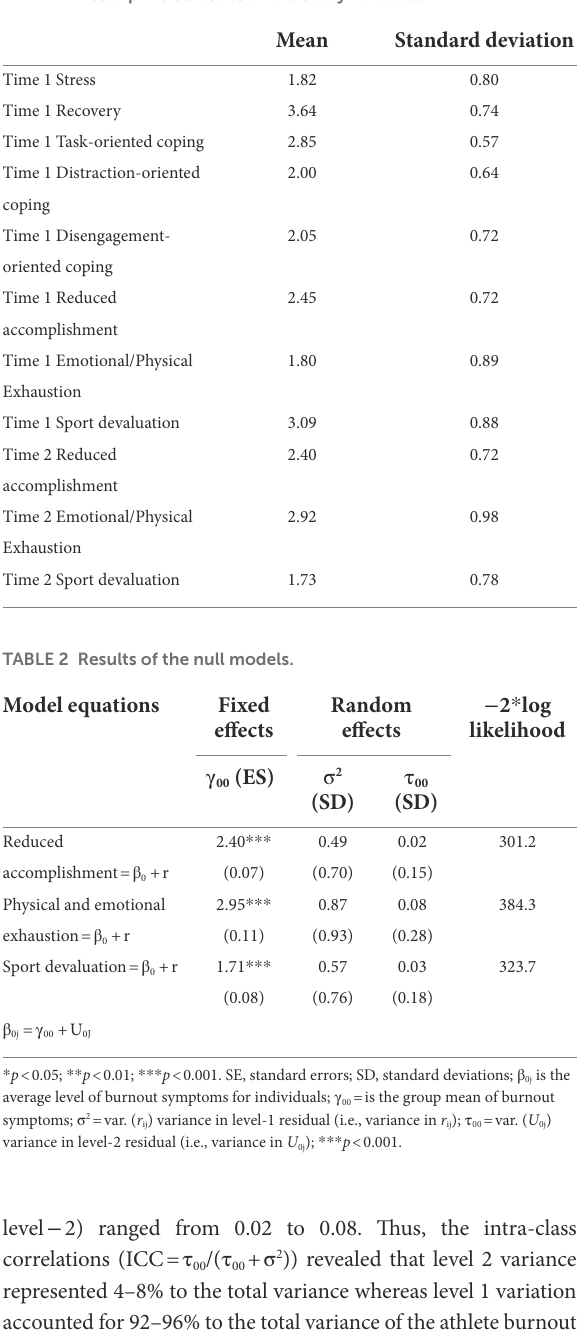
TABLE 1 Descriptive statistics of the study variables.